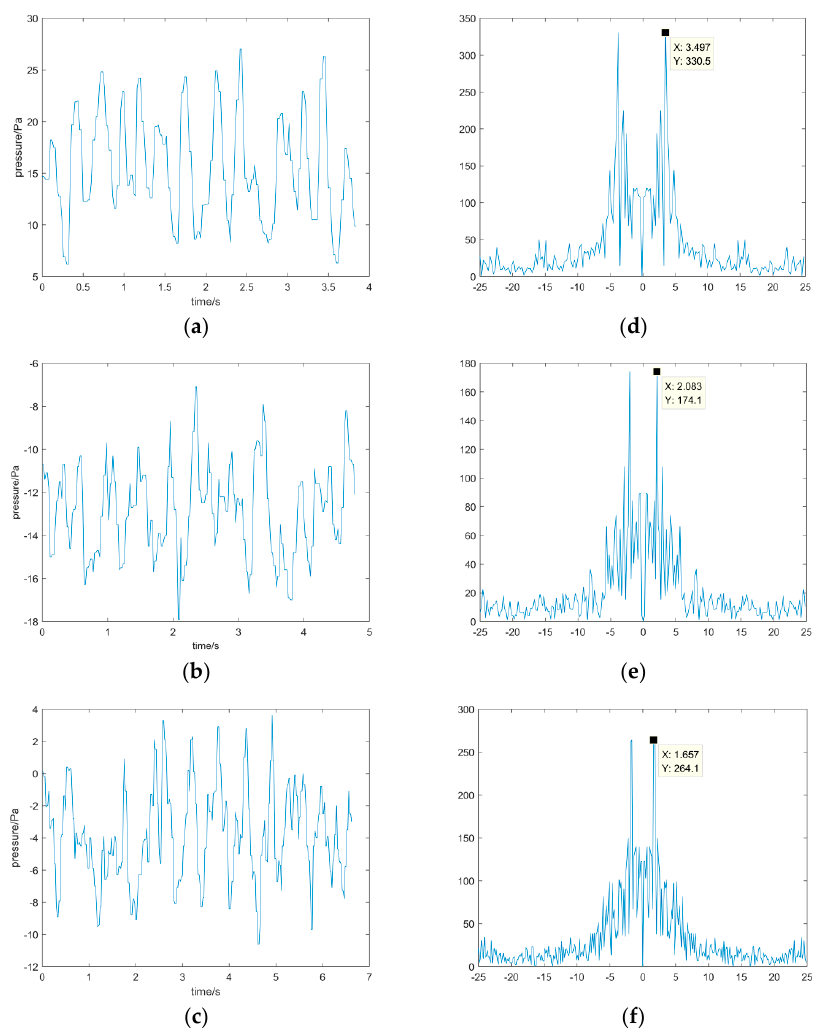
Figure 11. Pressure change in the hole and the frequency spectrum curve of cylinders with different diameters. ( a ) Variation of pressure around a 3 cm cylinder with time. ( b ) Variation of pressure around a 5 cm cylinder with time. ( c ) Variation of pressure around a 9 cm cylinder with time. ( d ) Analysis of pressure spectrum around 3 cm cylinder. ( e ) Analysis of pressure spectrum around 5 cm cylinder. ( f ) Analysis of pressure spectrum around 9 cm